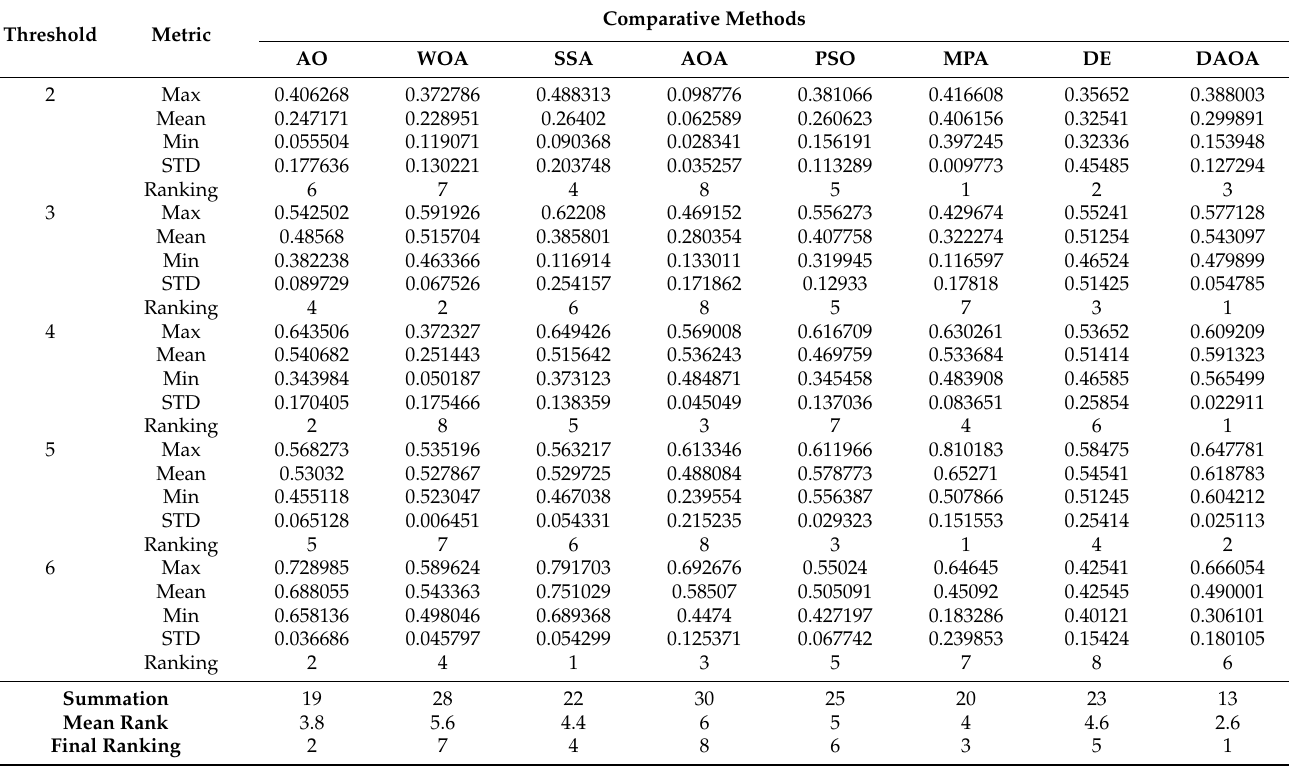
Table 5. The SSIM results of the test case